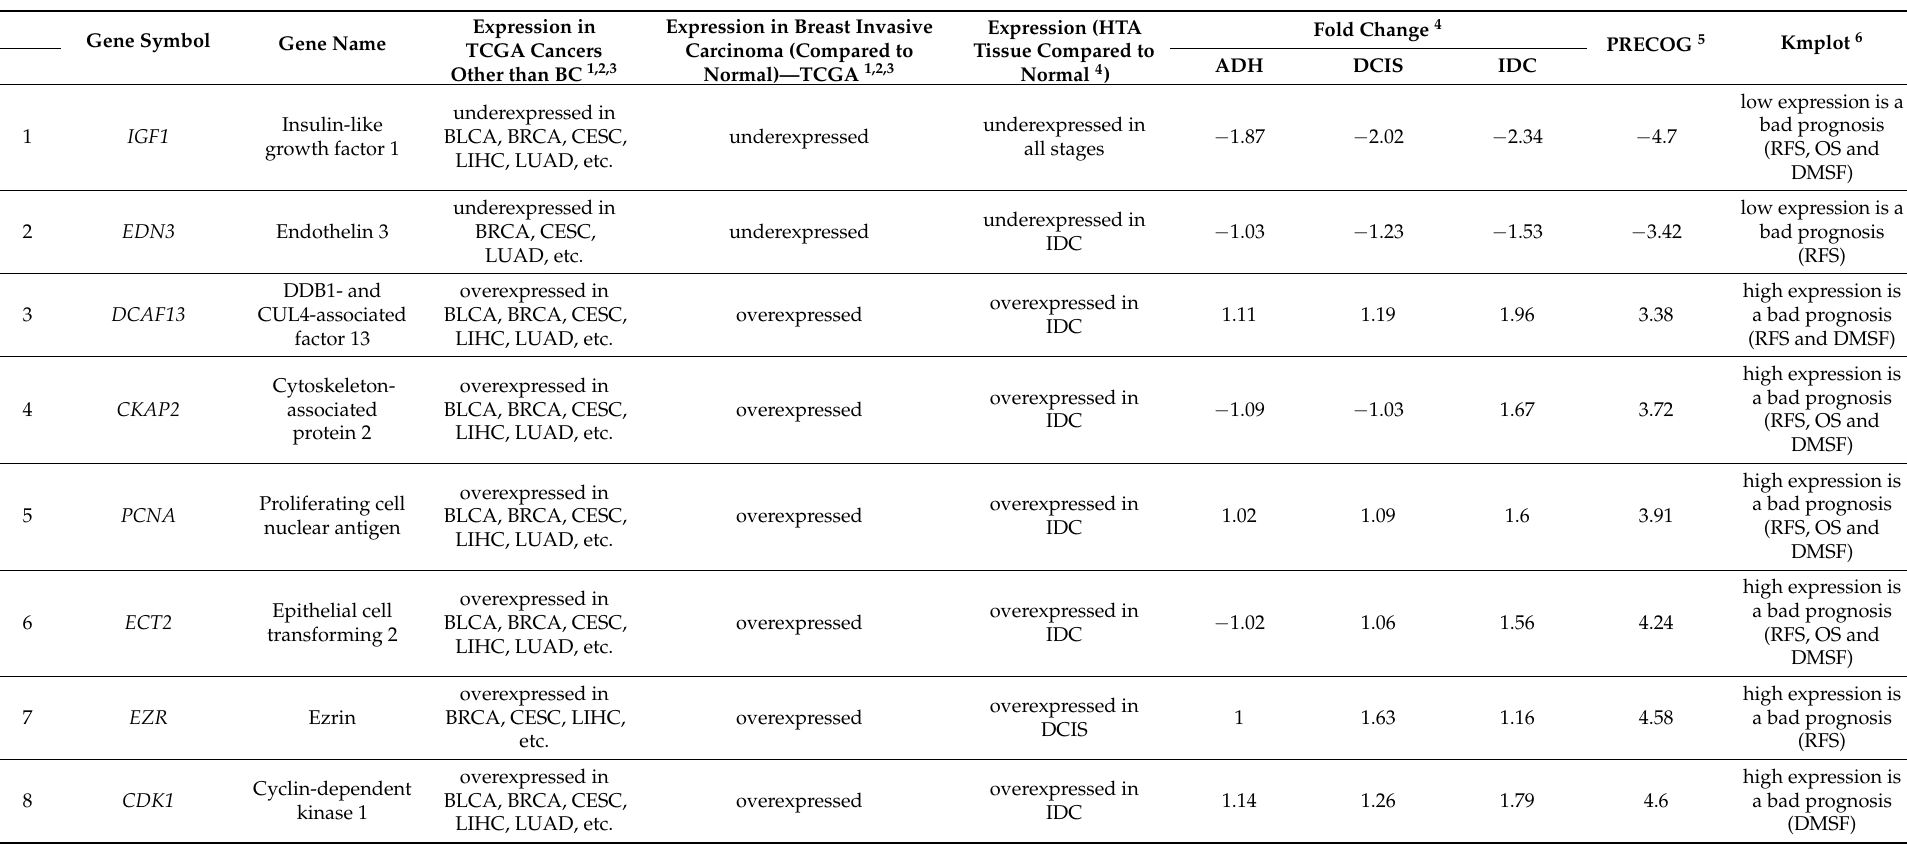
Table 1. The 24 mitotically relevant genes related to prognosis in breast cancer identified in this study (genes highlighted in green or gray are downregulated or upregulated, respectively). 1 TCGA-BRCA dataset (https://www.cbioportal.org/, accessed on 26 January 2022); 2 UALCAN (http://ualcan.path.uab.edu/, accessed on 21 November 2021); 3 GEPIA (http://gepia.cancer-pku.cn/, accessed on 28 October 2021); 4 HTA data from Kothari and colleagues (2018); 5 PRECOG (https://precog.stanford.edu/, accessed on 1 June 2021); 6 KMplot (https://kmplot.com/, accessed on 1 October 2021). ADH: atypical ductal hyperplasia;